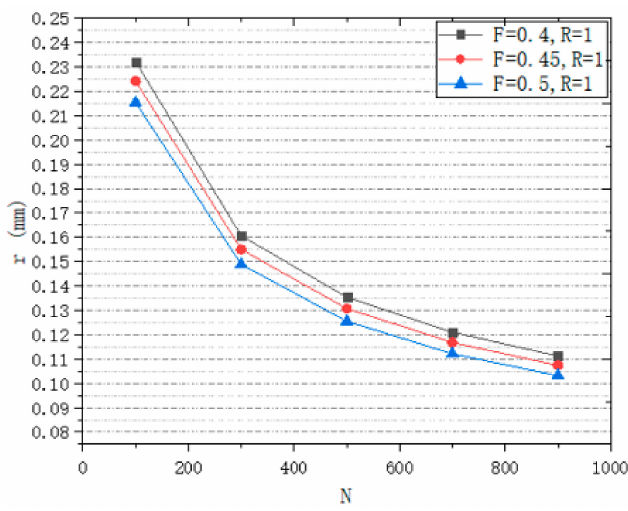
Figure 17. Relationship between N and